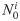
Overview of the workflow used to analyze the experimental data.Panel A shows the linear regression procedure to determine the number of engrafted tumor cells N0i and the growth rate constant ai for each mouse i from the untreated tumor bearing mice of the control group. In Panel B, the mean growth rate constant a¯ from the animals of this control group was used to determine the number of engrafted tumor cells in the groups of animals that were treated with radiotherapy or chemotherapy by using only the data points which were unaffected by therapy because we need a parametrization of the normal growth behavior of the tumor since the therapy effect will be modelled separately. Using this approach, the effects of the therapy do not affect the parametrization of the growth function. Panel C shows the approach to determine the spreading behavior in the control group, which is represented by the colonization coefficient m and the fractal dimension δ. Parameters were determined in two different ways: (I) from the experimentally determined numbers of disseminated tumor cells (DTC) and (II) from the experimentally numbers of circulating tumor cells (CTC). For the mouse with the biggest tumor we choose a fractal dimension of 2, which implies a blood supply on the surface of the tumor, to determine the colonization coefficient. Afterwards, we calculated with these data all other parameters for the remaining mice in the control group. In Panel D, the determined parameter m will be used to compute the fractal dimension δ in treated groups with its own growth parameters which were determined in panel B.